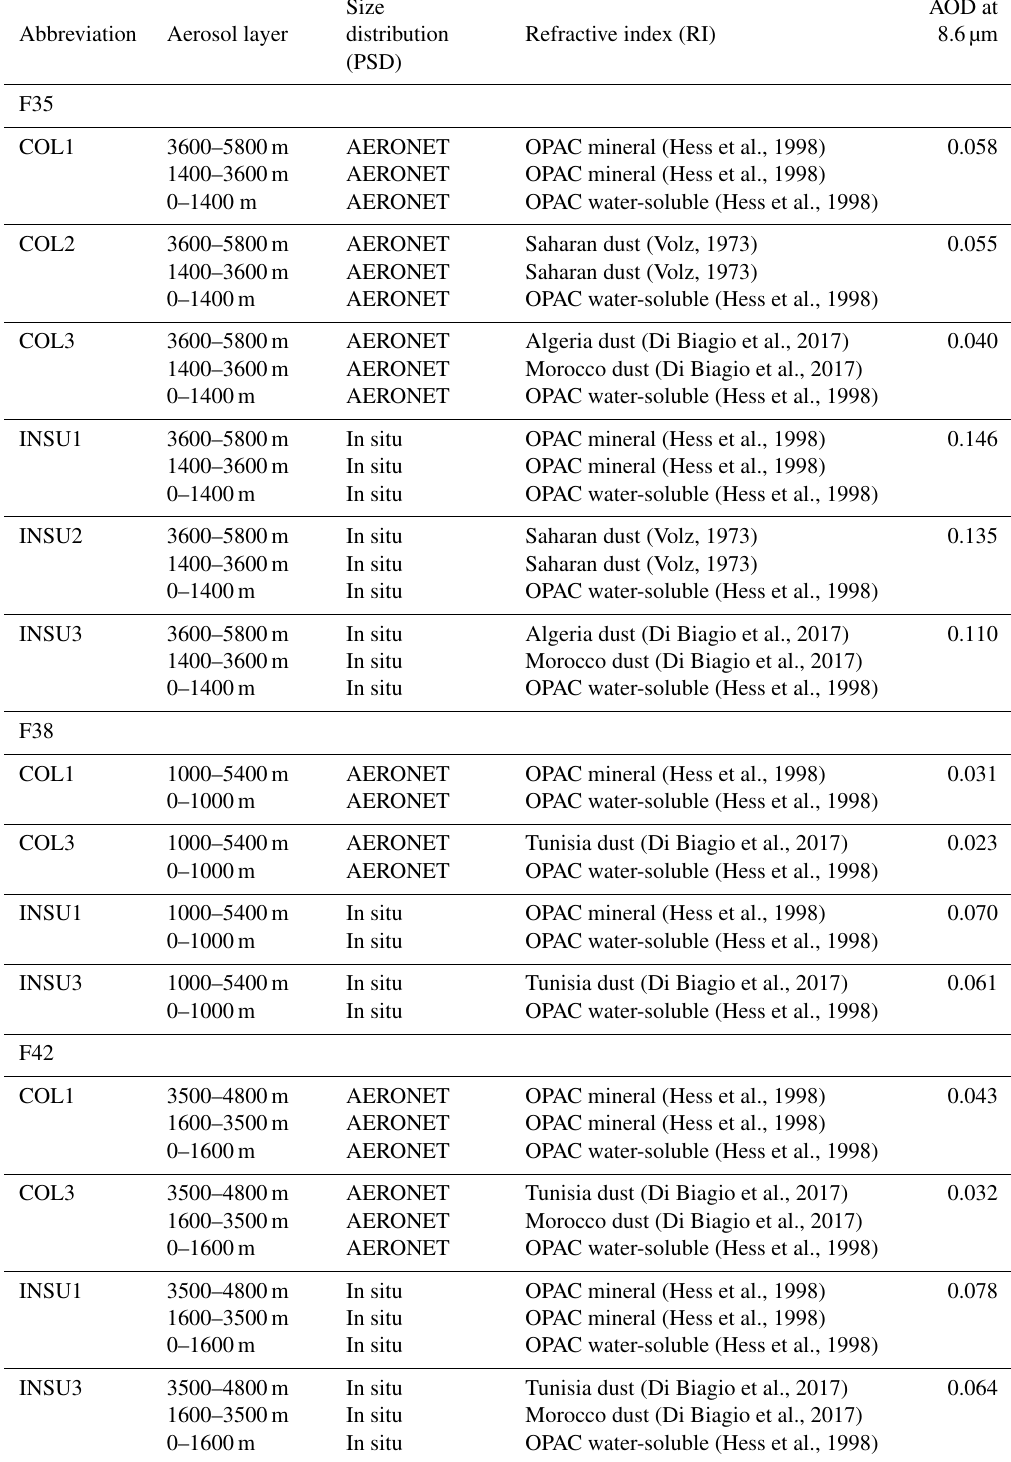
Table 2. Summary of the size distributions and complex refractive index combinations used to calculate AOPs in the infrared spectral interval. The abbreviations for each combination and for aerosol-free conditions are reported in the first column. The column AOD at 8.6µm is also